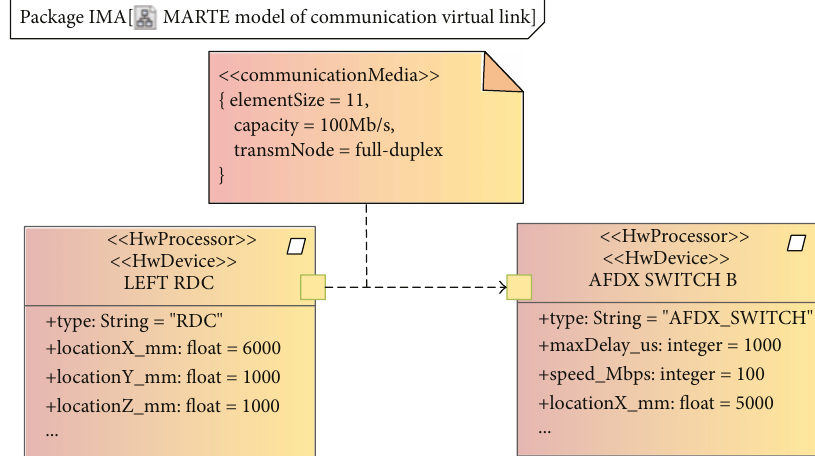
Figure 7: MARTE model of communication virtual link.